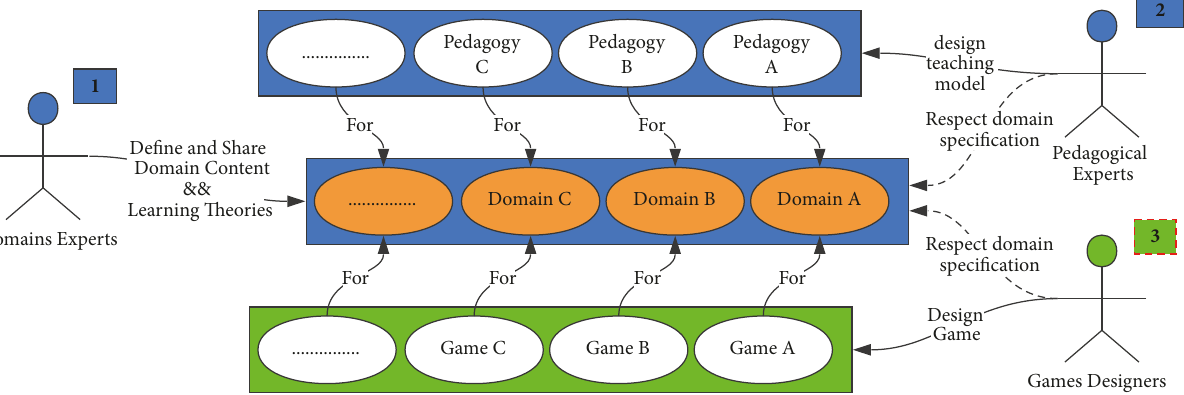
Figure 5: Presentation of serious games production process according to the proposed architecture; the numbers in the squares represent intervention